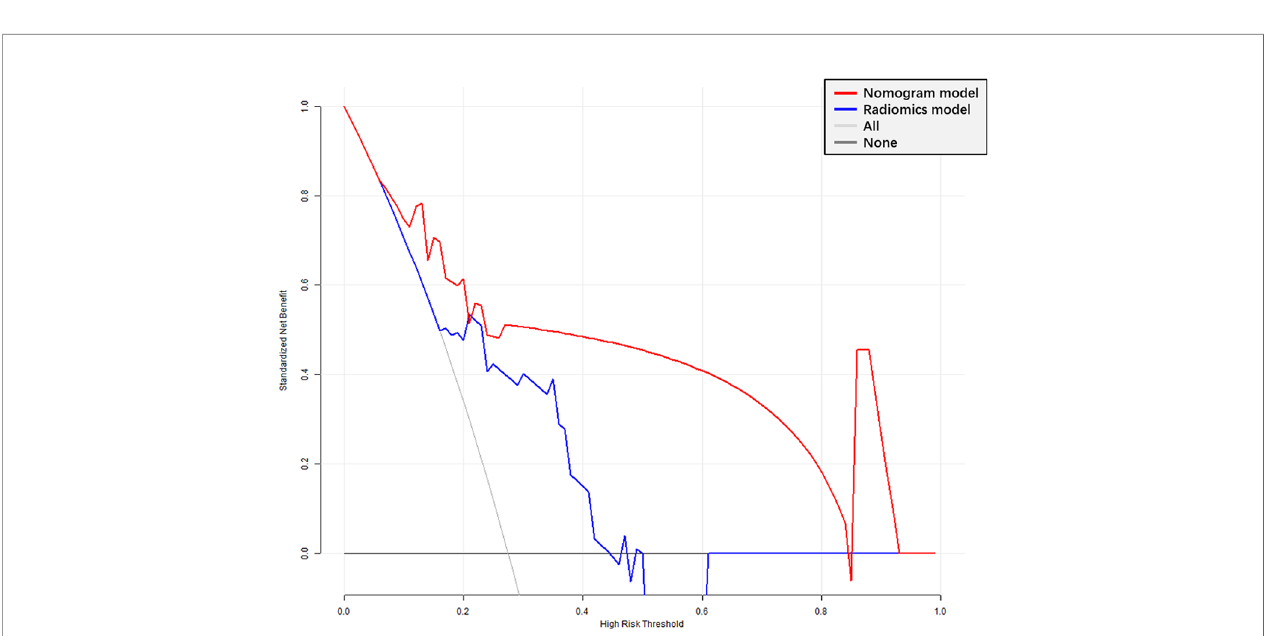
FIGURE 7 | Decision curve analysis (DCA) of the radiomics signature and nomogram models. X-axis, probability of poor response to nCRT; Y-axis, net bene fi t. Black line, all patients assumed to be good responders; gray line, all patients considered poor responders. The nomogram model had enhanced net bene fi t compared with the radiomics signature in almost all threshold probabilities.